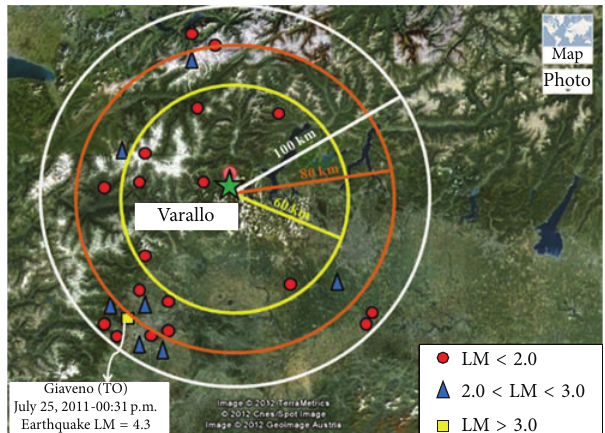
Figure 8: Seismic events around Varallo (Italy) from May, 2011 to September, 2011 (LM: local magnitude).